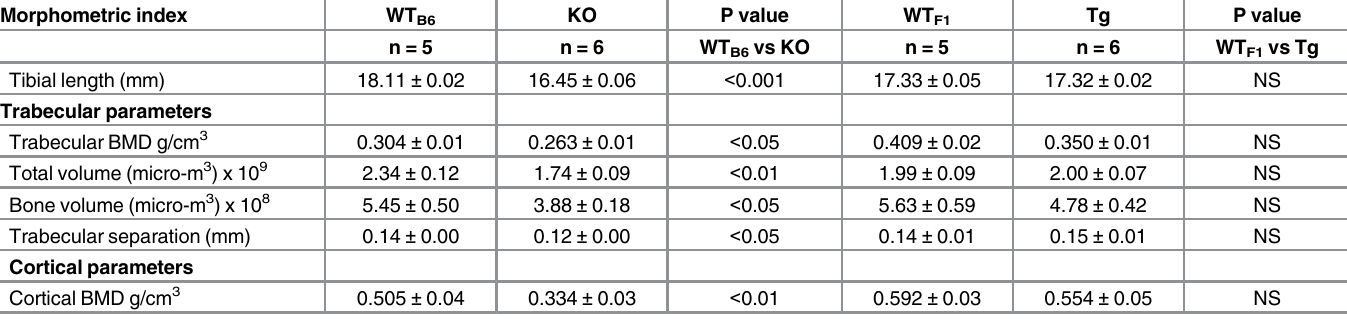
Table 1. Mean value of morphometric parameters from the 2D and 3D analysis representing trabecular and cortical mass and architecture of WT B6 , Timp-3 KO, WT F1 and Timp-3 Tg mice at 8 weeks of age.